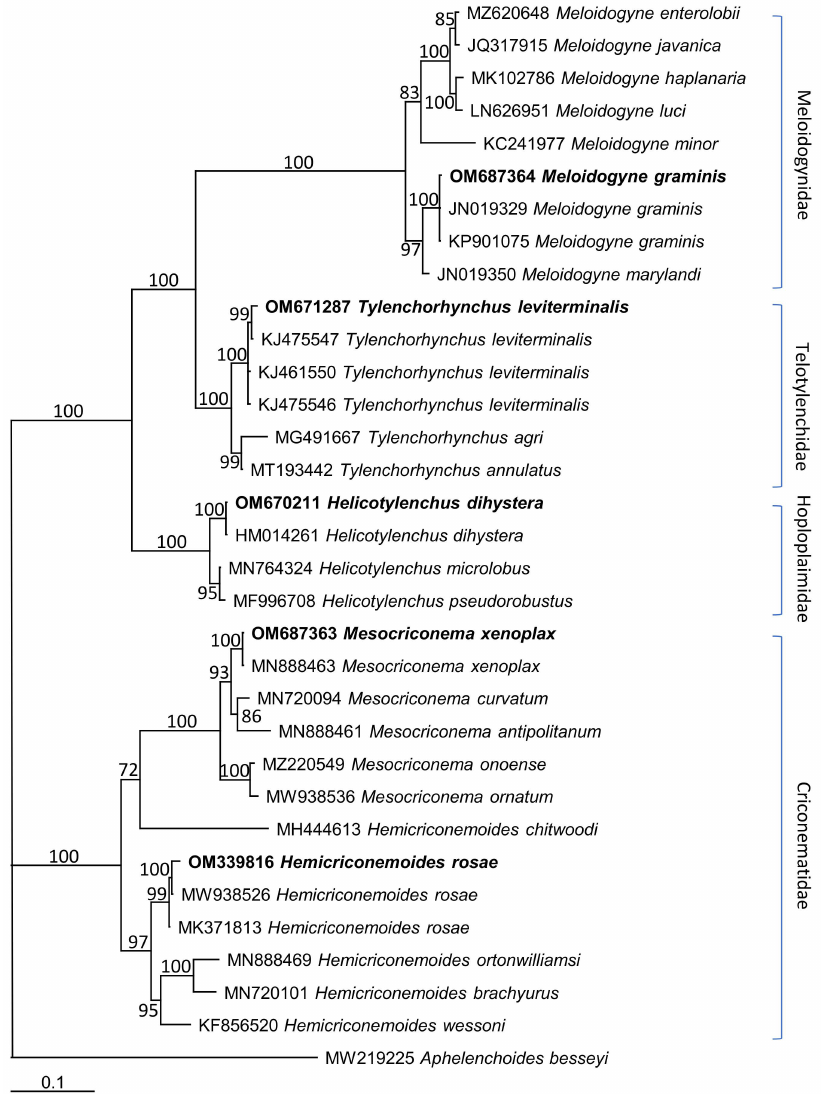
Figure 7. The 10,001st Bayesian tree inferred from D2-D3 under the GTR+I+G model (lnL = 5789.4619; freqA = 0.1932; freqC = 0.2222; freqG = 0.3323; freqT = 0.2523; R(a) = 0.6368; R(b) = 2.4422; R(c) = 1.4785; R(d) = 0.3450; R(e) = 3.8018; R(f) = 1; Pinvar = 0.2939; Shape = 1.3309). Posterior probability values exceeding 50% are given on appropriate clades. The new species is in bold